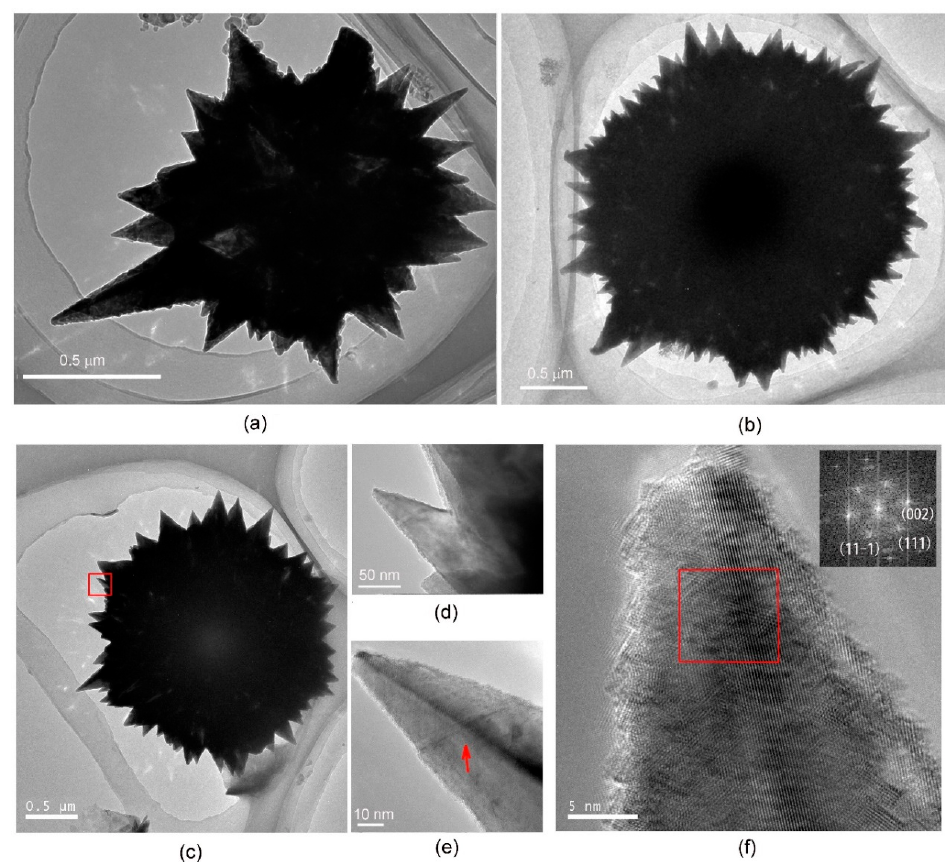
Figure 5. TEM images of an Ni microflower ( a ), an Ni microsphere ( b ), and an Ni microsphere at different magnifications ( c – f ). Inset of Figure 5f is the corresponding reduced fast Fourier transform image of the framed region.